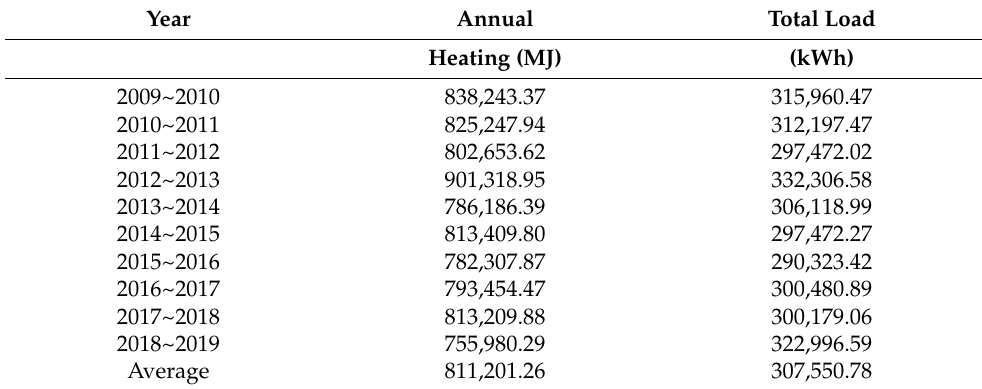
Table 1. Annual energy loads of the experimental greenhouse